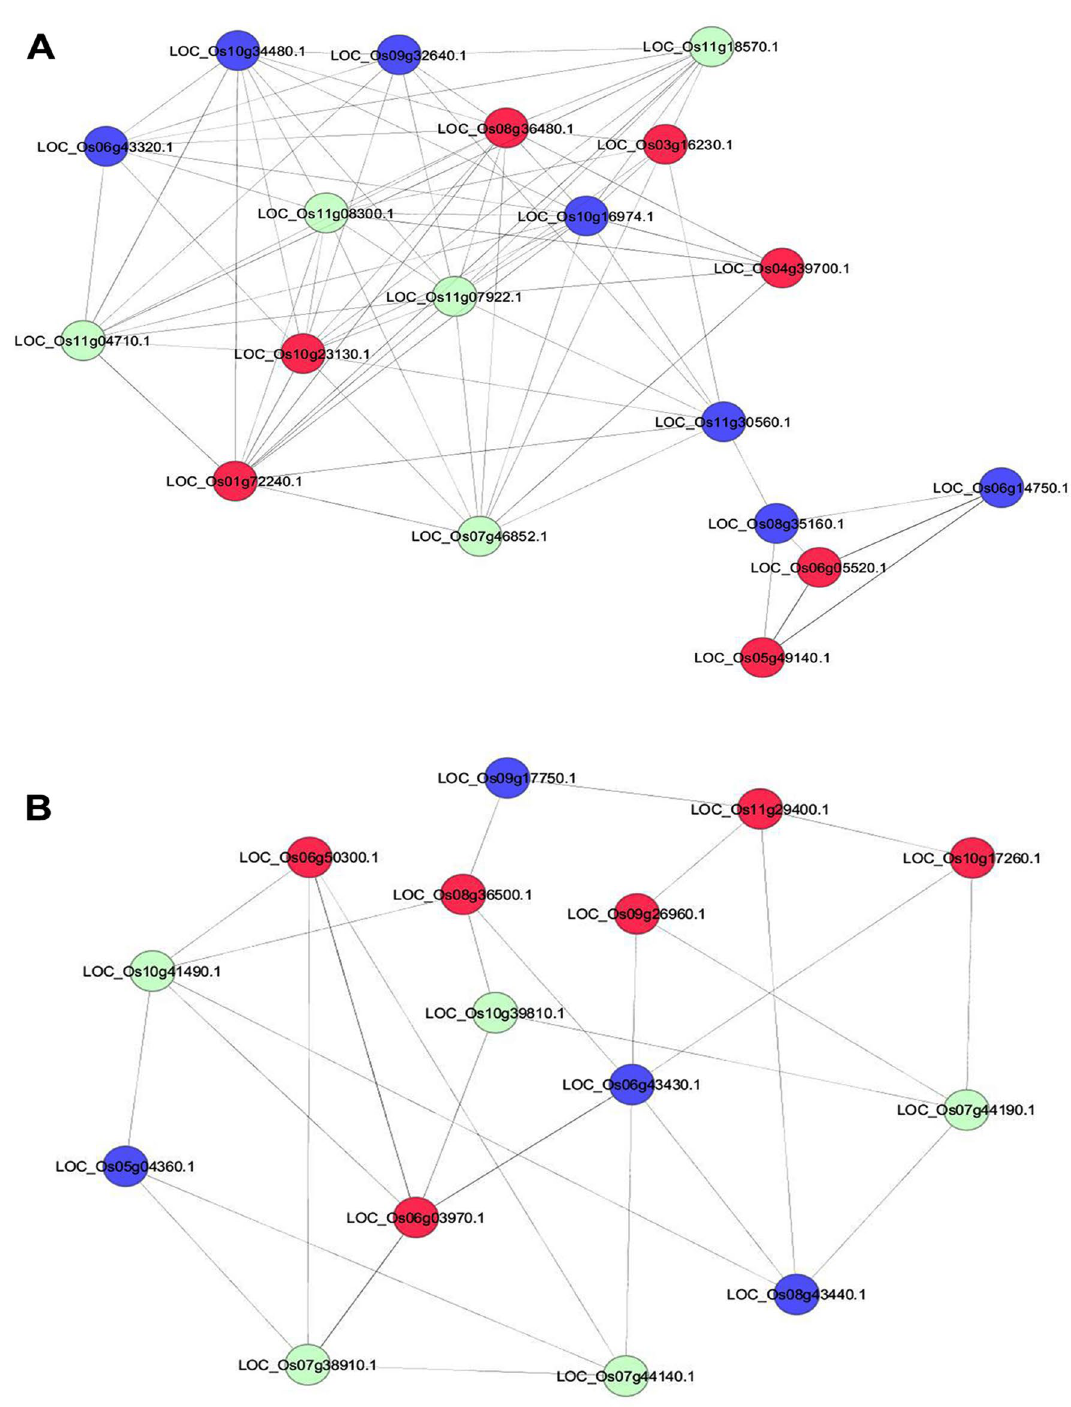
Figure 7. RGA1-regulated molecular complexes associated with different cellular pathways. All the DEGs identified in our study were used to retrieve the experimentally validated interactors from BioGRID, STRING and other databases. The protein–protein interaction (PPI) networks were constructed using DEGs-associated interactors in Cytoscape and molecular complexes were identified using the MCODE plugin in Cytoscape. Representative RGA1-regulated molecular complexes are shown ( A and B ) and the rest of the identified molecular complexes are given in Fig. S6–S11. The red and blue nodes represent the up- and down-regulated DEGs, respectively. Interactors that are not DEGs are assigned with light